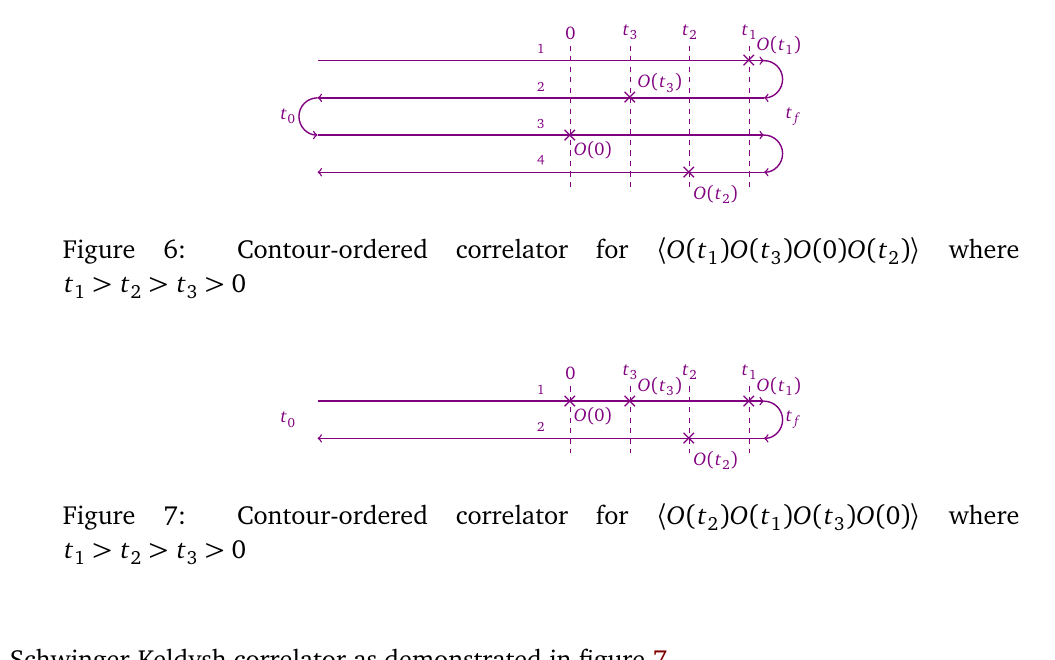
) O ( t ) O ( t ) O ( 0 ) 〉 where 2 1 3